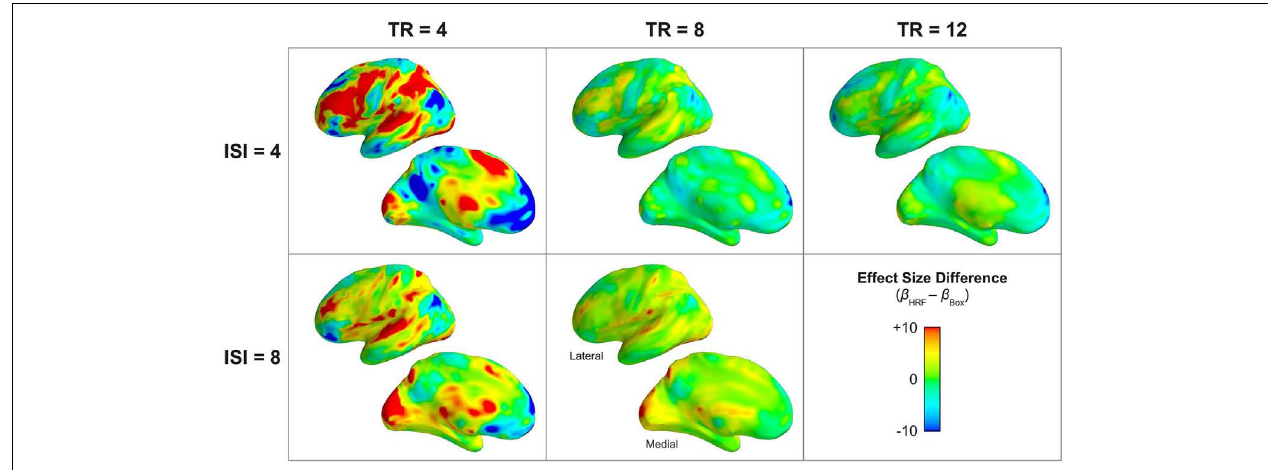
are, in fact, areas corresponding to the default mode network with corresponding task-related deactivation ( Figure 7 ).Thus, for medial prefrontal, posterior cingulate, inferior parietal, superior frontal, and temporal pole, the HRF model estimated larger magnitude “deactivations” than the boxcar model. A parameter estimate of 10 corresponds to a 1% signal change.The lateral and medial surfaces of the left hemisphere are shown. Supplementary Figure 3 provides a volume-based depiction (axial slices) of these